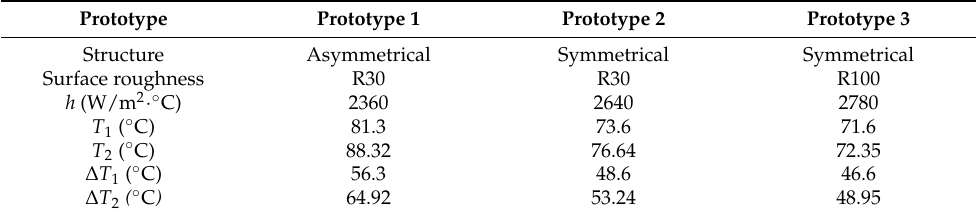
Figure 8. Temperature curves of the barrel conductors with different structures and surface roughness. Table 7. Comparison between simulation and experiment of the barrel conductor with different structures and surface roughness.